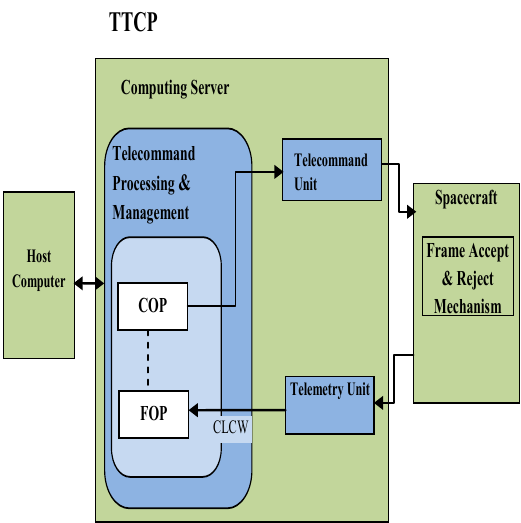
Figure 2 . COP, FOP and FARM